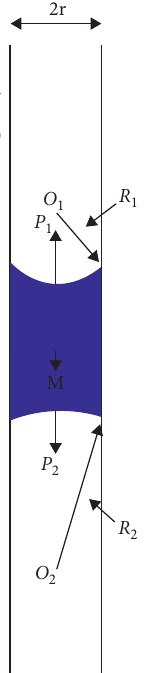
Figure 14: Diagram of soil water holding